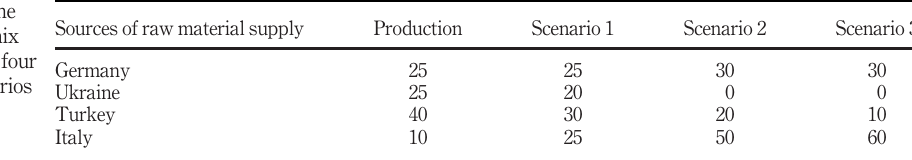
Table I. Composition of the current supply mix (production) and four alternative scenarios (expressed in